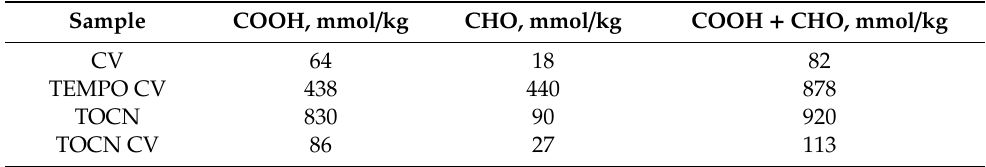
Table 2. Content of functional groups of TEMPO oxidized cellulose nanofibrils (TOCN), pristine and pretreated viscose